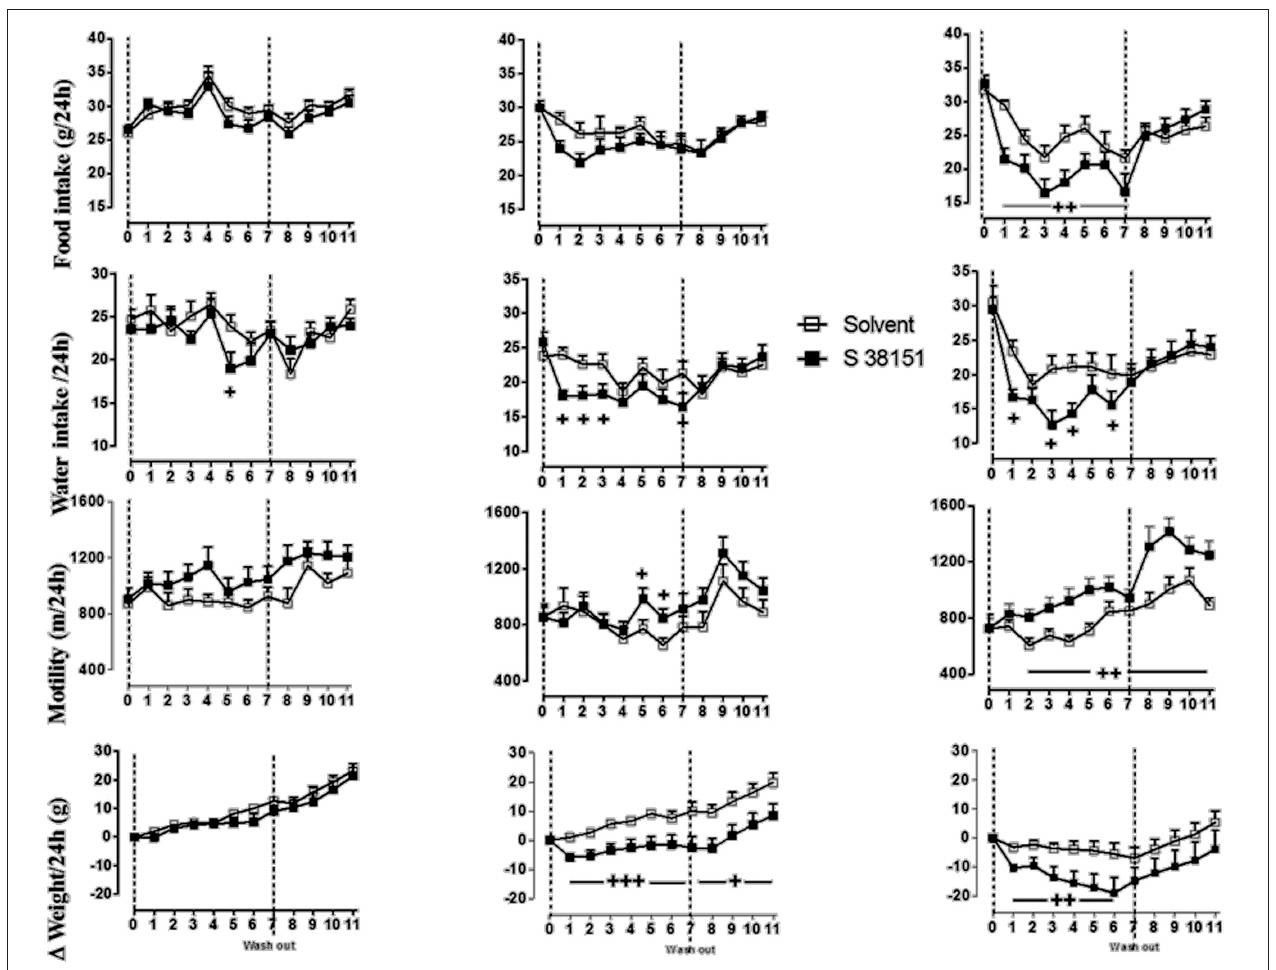
FIGURE 4 | The effects of repeated daily central administration of S38151 on food intake, water intake, body weight, and motility in Zucker fa/fa rats. One hour prior the beginning of the dark phase, different doses of S38151 (5, 10, or 20nmol/kg) or vehicle were injected (i.c.v.) once daily for 7 days, followed by a washout period of 5 days.